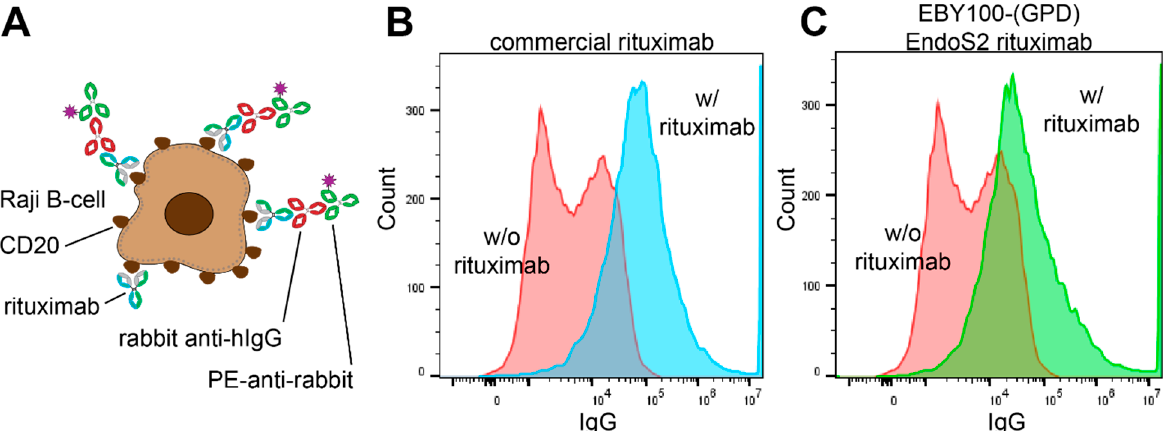
Figure 7. Binding of yeast-expressed Rituximab to Raji B cells. ( A ) Schematic diagram of the detection strategy. Flow cytometry analysis of Raji B cells incubated with the two detection antibodies shown in panel A, with or without commercially sourced Rituximab ( B ) or EBY100-(GPD) EndoS2 expressed Rituximab( C ).